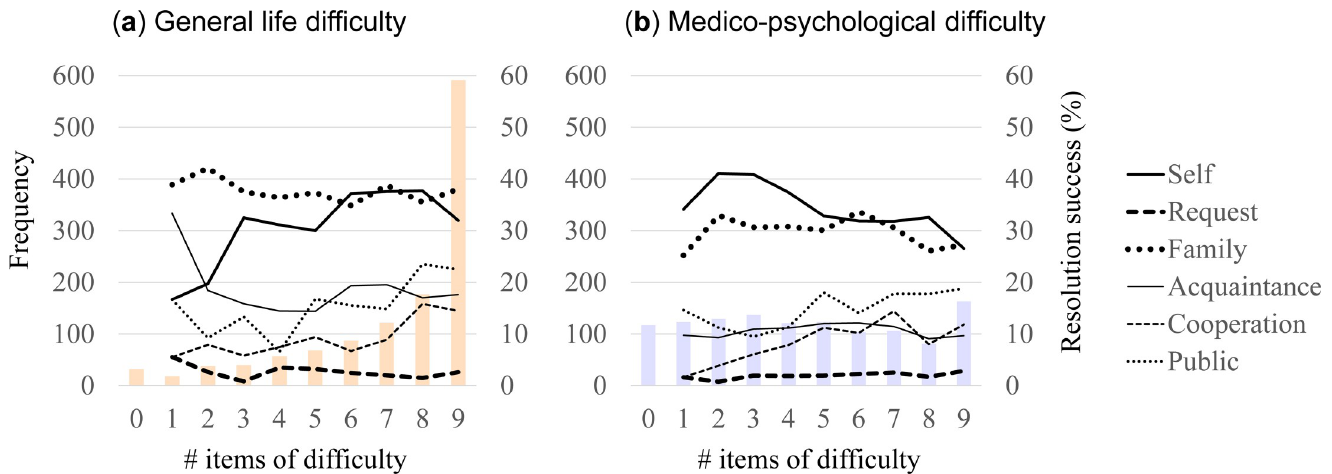
Fig 2. Characteristics of two difficulty types. Distribution of the degree (frequency) of difficulty experienced (bar graph) and its relationship to the solution success rate (%), with different lines representing the six solution types (see legend at right), are shown for general life difficulty ( a ) and medico-psychological difficulty ( b ).